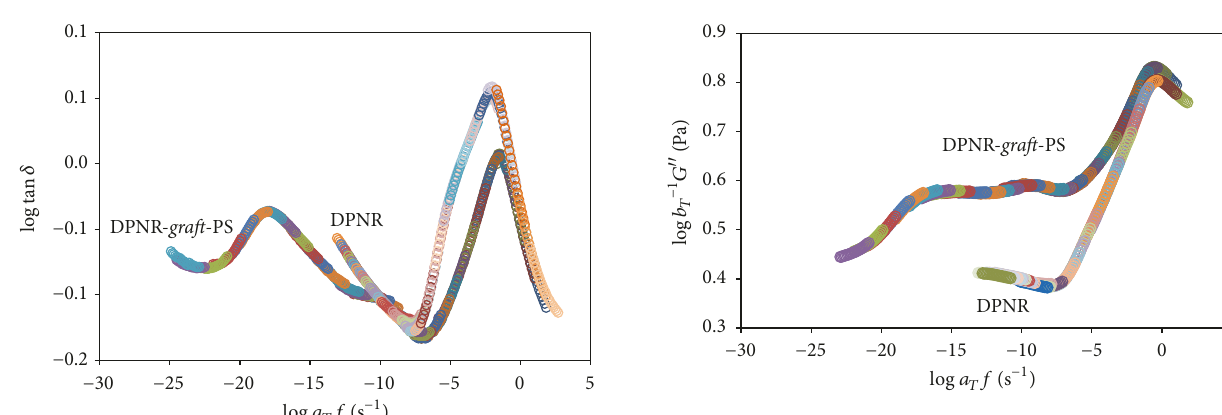
Figure 8: Master curves of loss modulus for DPNR and DPNR- graft -PS.